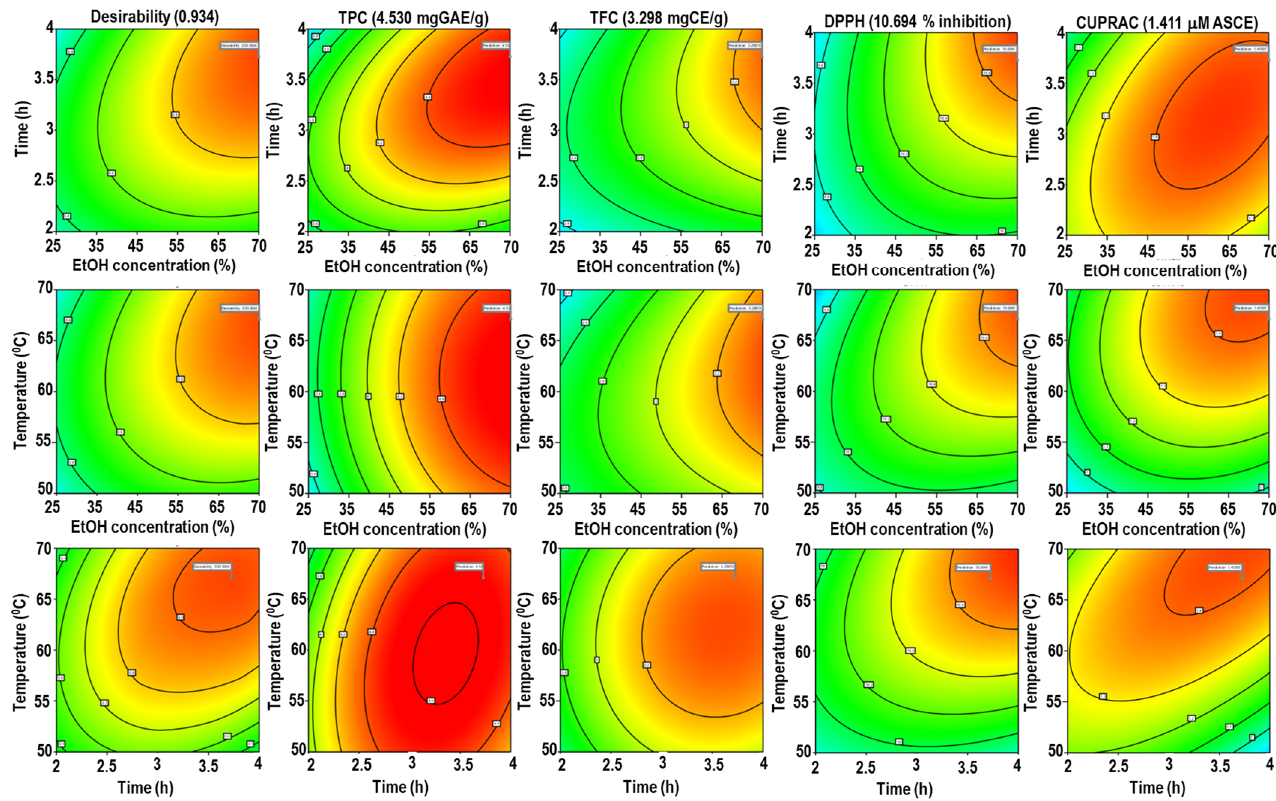
Figure 2. Desirability surface plot as a function of ethanol concentration, extraction time, and temperature for TPC, TFC, DPPH, and CUPRAC. Table 4. Experiment data of the validation of predicted values at optimal extraction conditions of RADP.